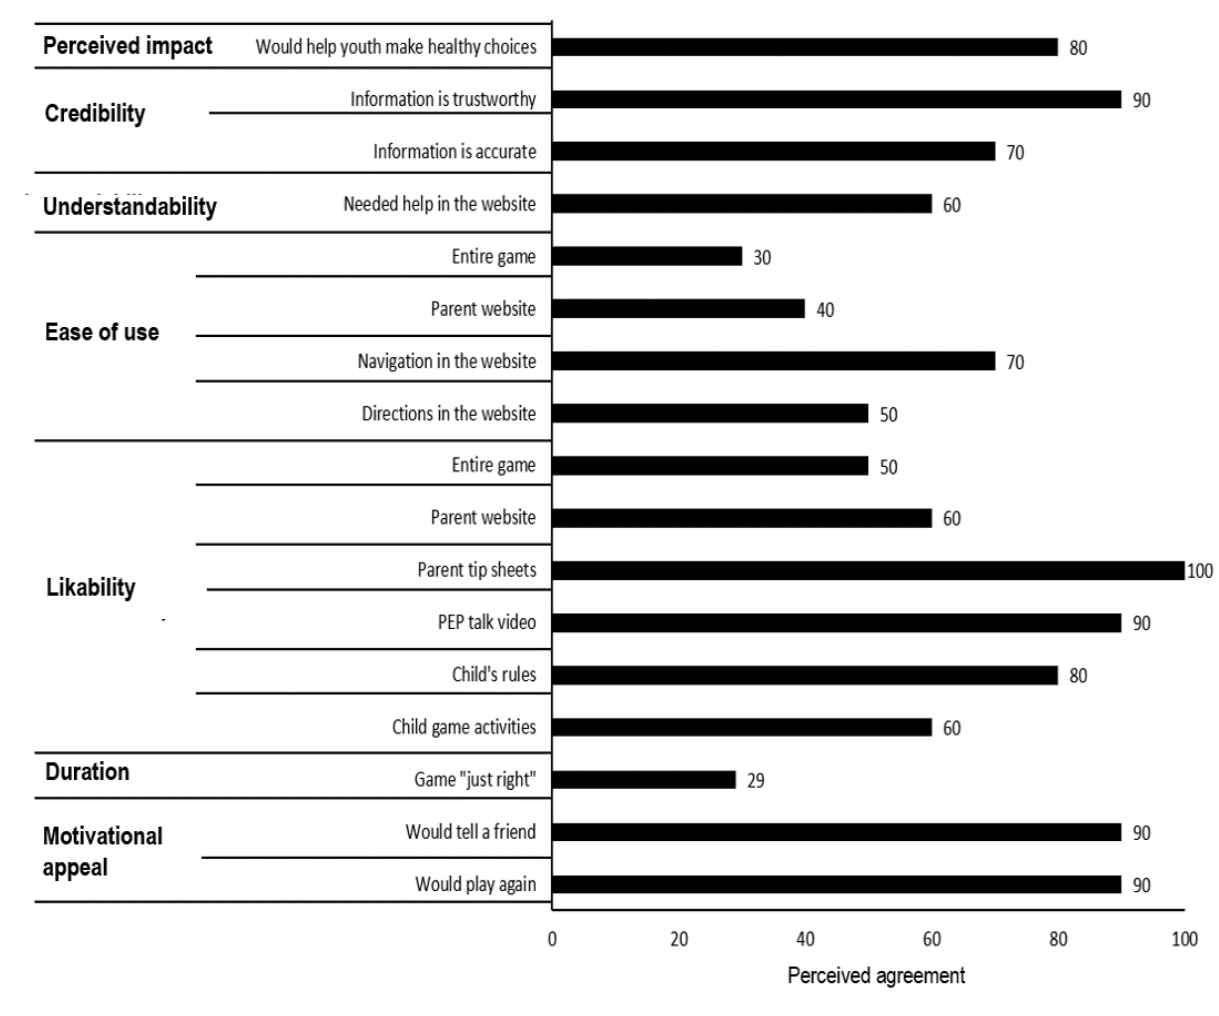
Figure 5. Parent ratings for parent website and prototype levels 1 and